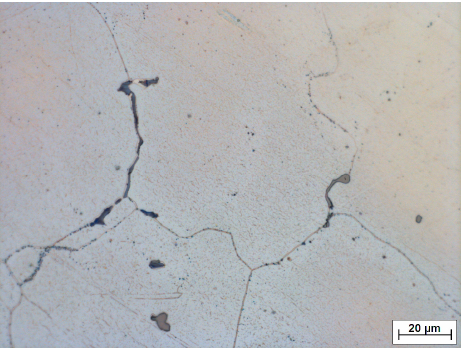
Figure 4. Temperature dependence of amplitudes necessary for achieving damping values of δ H = 1 × 10 − 3 and δ H = 5 × 10 − 3 .